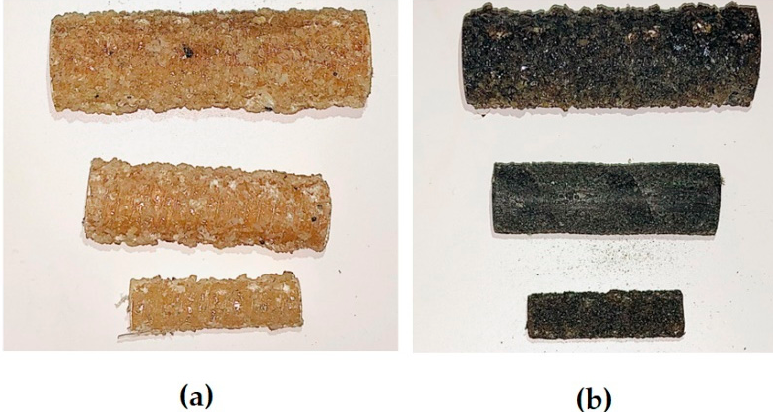
Figure 1. Samples of ( a ) the glass fiber-reinforced polymer (GFRP) and ( b ) basalt fiber-reinforced polymer (BFRP) bars used in this study .